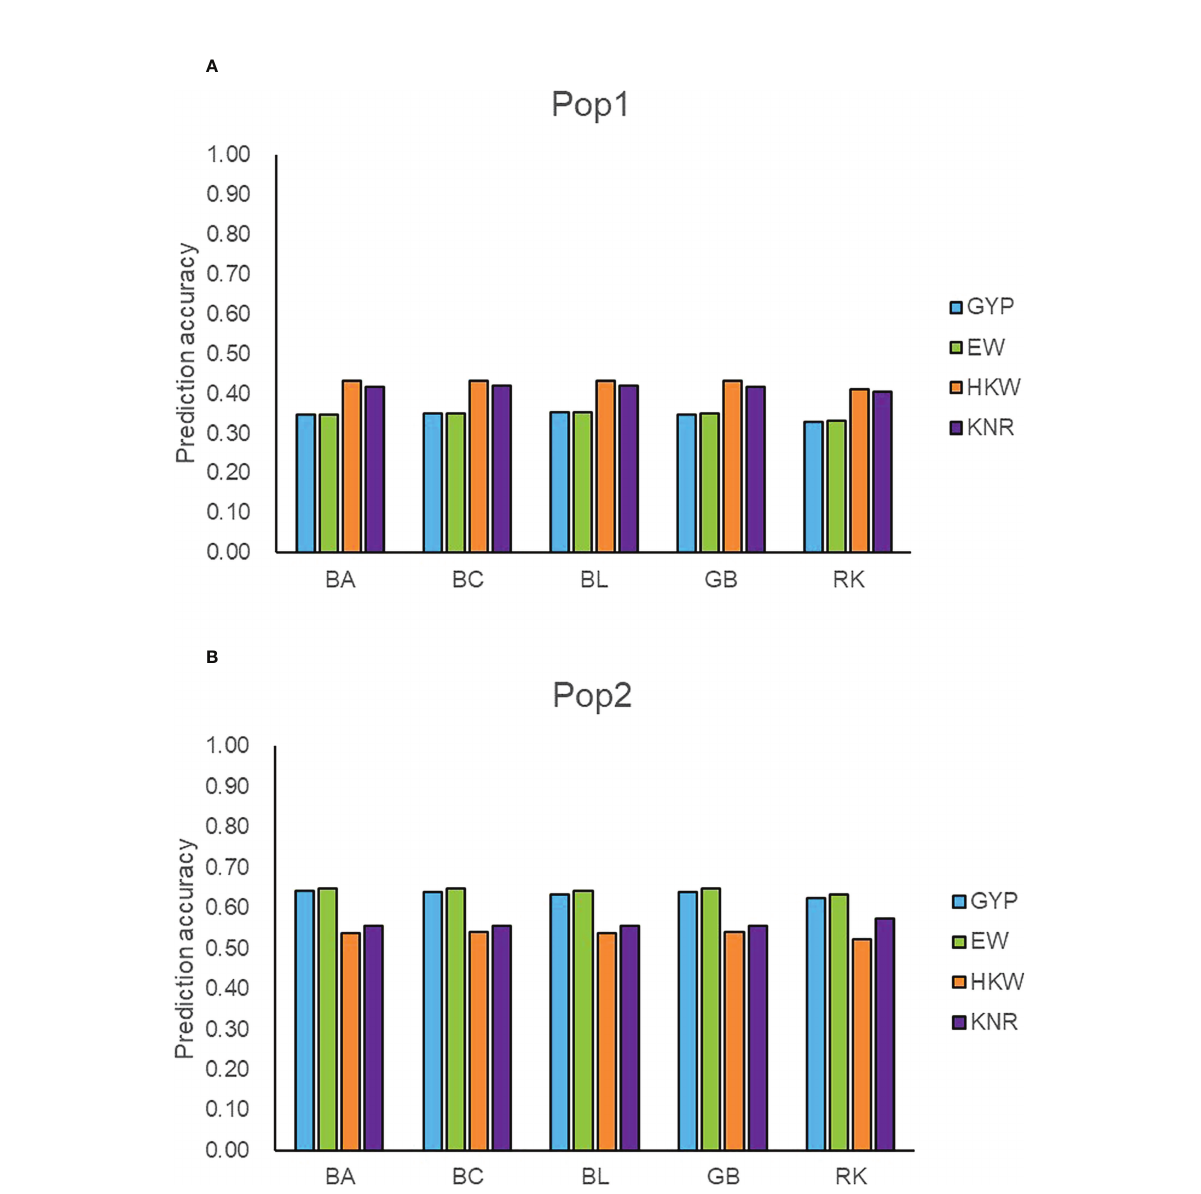
FIGURE 3 Accuracy of fi ve models predicting general combining ability for four traits in two populations. (A) The prediction accuracy of GYP, EW, HKW, and KNR in Pop1. (B) The prediction accuracy of GYP, EW, HKW, and KNR in Pop2. GYP, EW, HKW, and KNR are abbreviations of grain yield per plant, ear weight, thousand-kernel weight, and kernel row number, respectively. BA, BC, BL, GB, and RK denote Bayes A, Bayes C, Bayesian LASSO, GBLUP and RKHS,